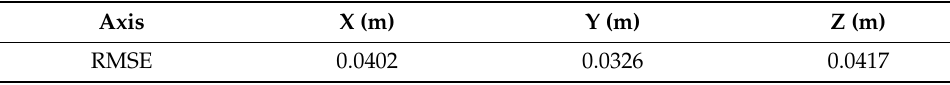
Table 2. RMSE of target tracking in Experiment 2.